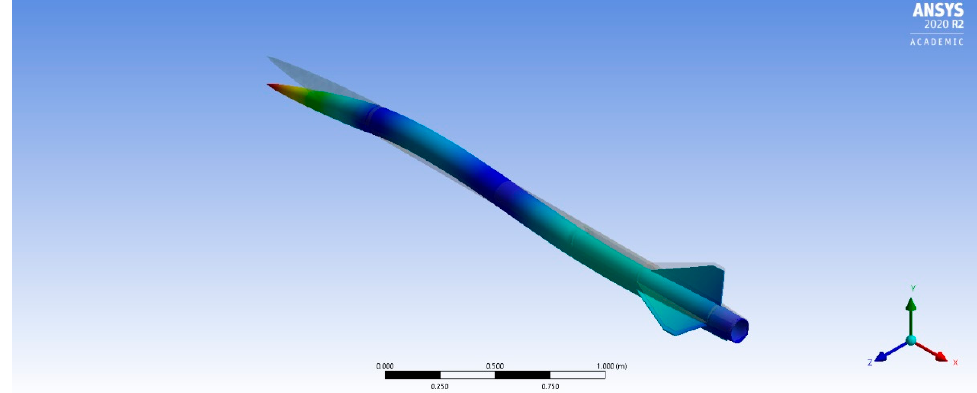
Figure 30. Second-Order Bending Mode Shape (X–Y Plane).